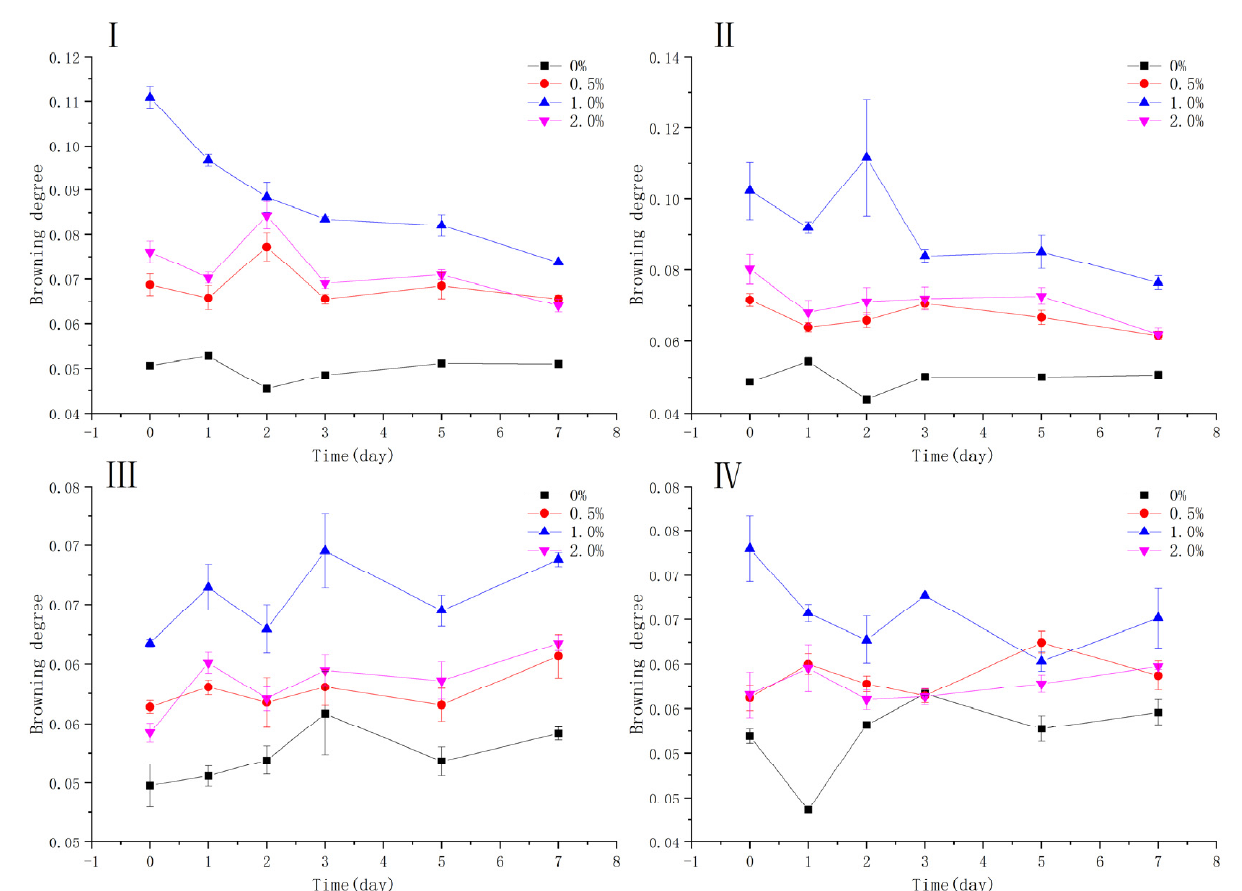
Figure 10. The browning degree of autoxidation browning products of ( I ) Catechin ( II ) Epicatechin ( III ) Caffeic acid ( IV ) Chlorogenic acid under the effect of different concentrations of eugenol.